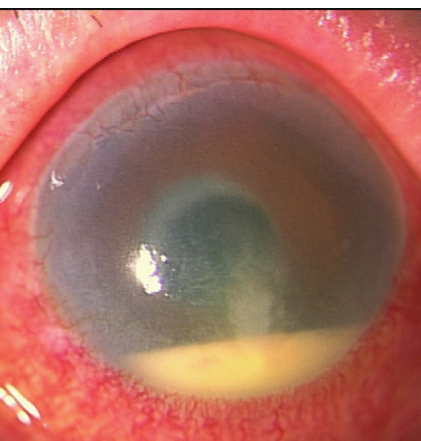
Figure 1: Photograph of the anterior segment in the left eye at the first visit. Hypopyon in the anterior chamber, ciliary hyperemia, and corneal epithelium and stoma edema were observed.